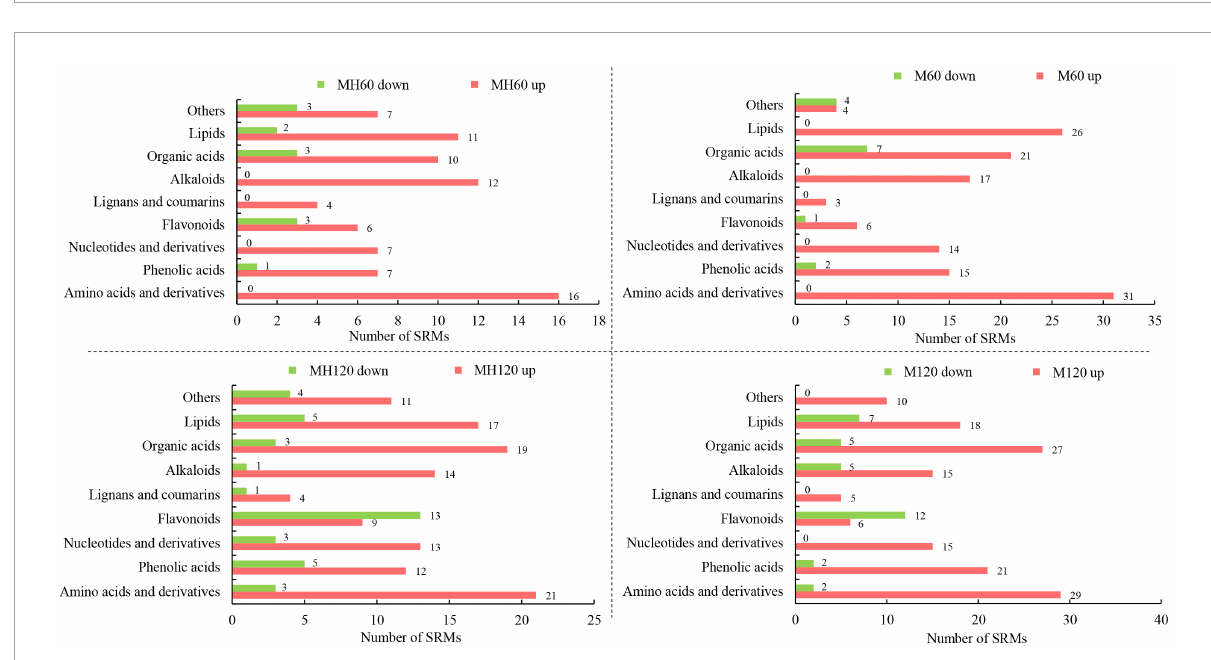
FIGURE6 Significantly regulated metabolite (SRM) classification of HD961 and